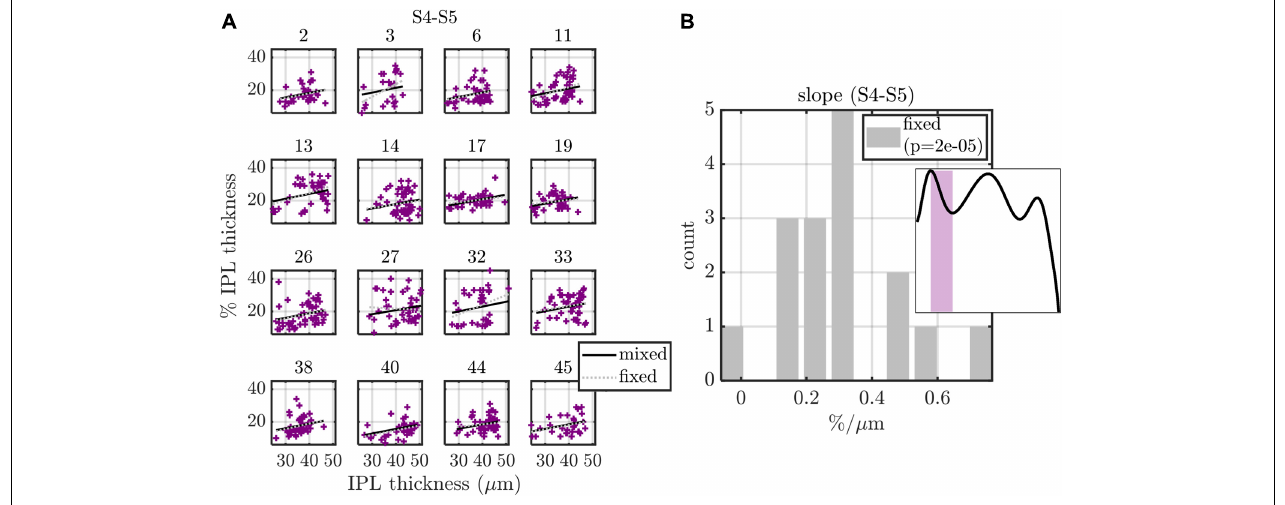
FIGURE 9 | Summary of fixed (fixed intercept and slope for each subject) and mixed (fixed intercept and slope, with independent random intercept and slope for each subject) effects models, applied to S4-S5 transition width versus IPL thickness. (A) Model fits are shown for each of the 16 subjects, with subject index in subplot titles. (B) Histogram of subject slopes from the fixed effects model shows a statistically significant positive slope. Similar analysis for other stratification parameters are summarized in Table 1 (eccentricity as a predictor) and Table 2 (IPL thickness as a predictor).